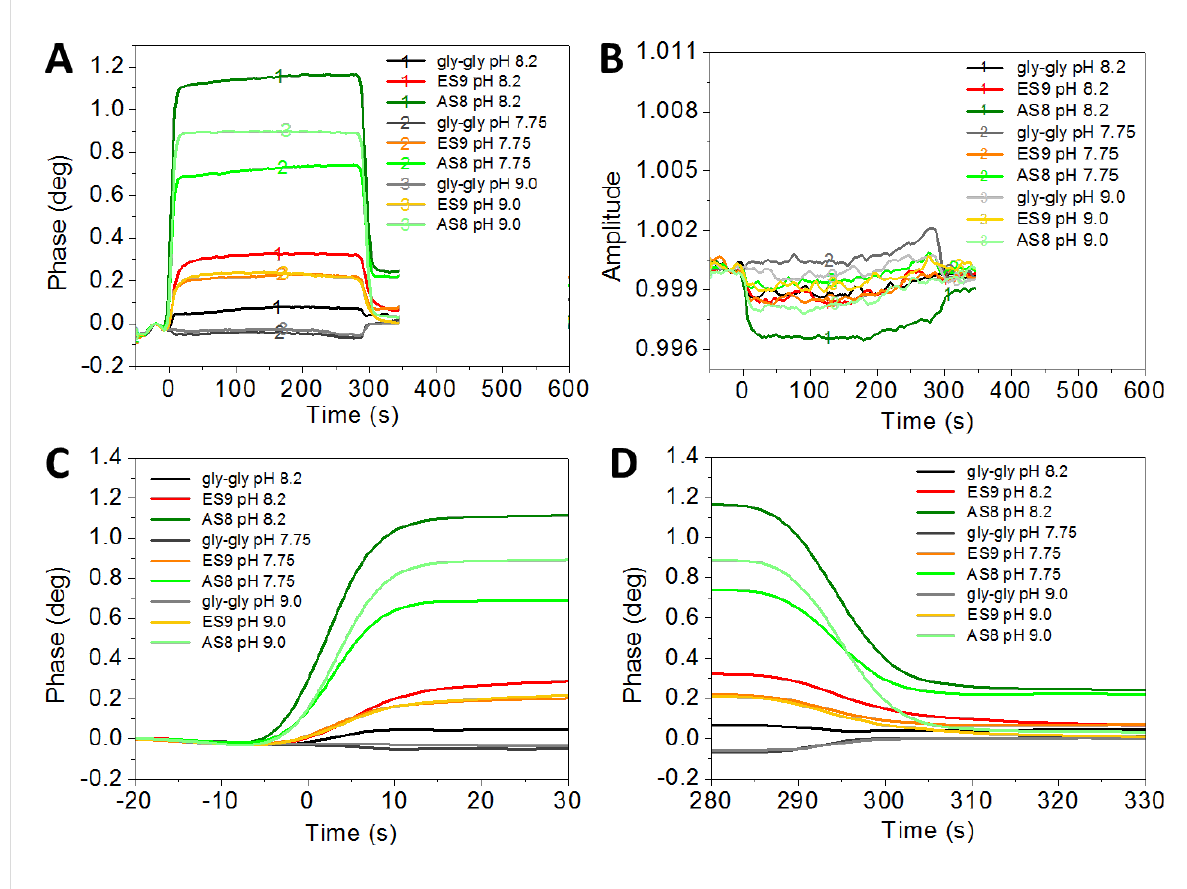
Figure 6: Monitoring of cationic peptides ES9 and AS8 on COO-SAM sensor surfaces. Phase (A) and corresponding amplitude (B) signal vs time for Gly–Gly pH 7.75, pH 8.2, or pH 9.0 with 200 µM peptides ES9 and AS8 (injection: 0–300 s). Graphs were produced by an overlay of data-sets (rows 2, 4, 6 of Table S4, Supporting Information File 1) at the time of injection (setpoint: 0 s). For clarity, the phase signals at the onset (C) and offset (D) of peptide injections are shown in time intervals of 50 seconds.